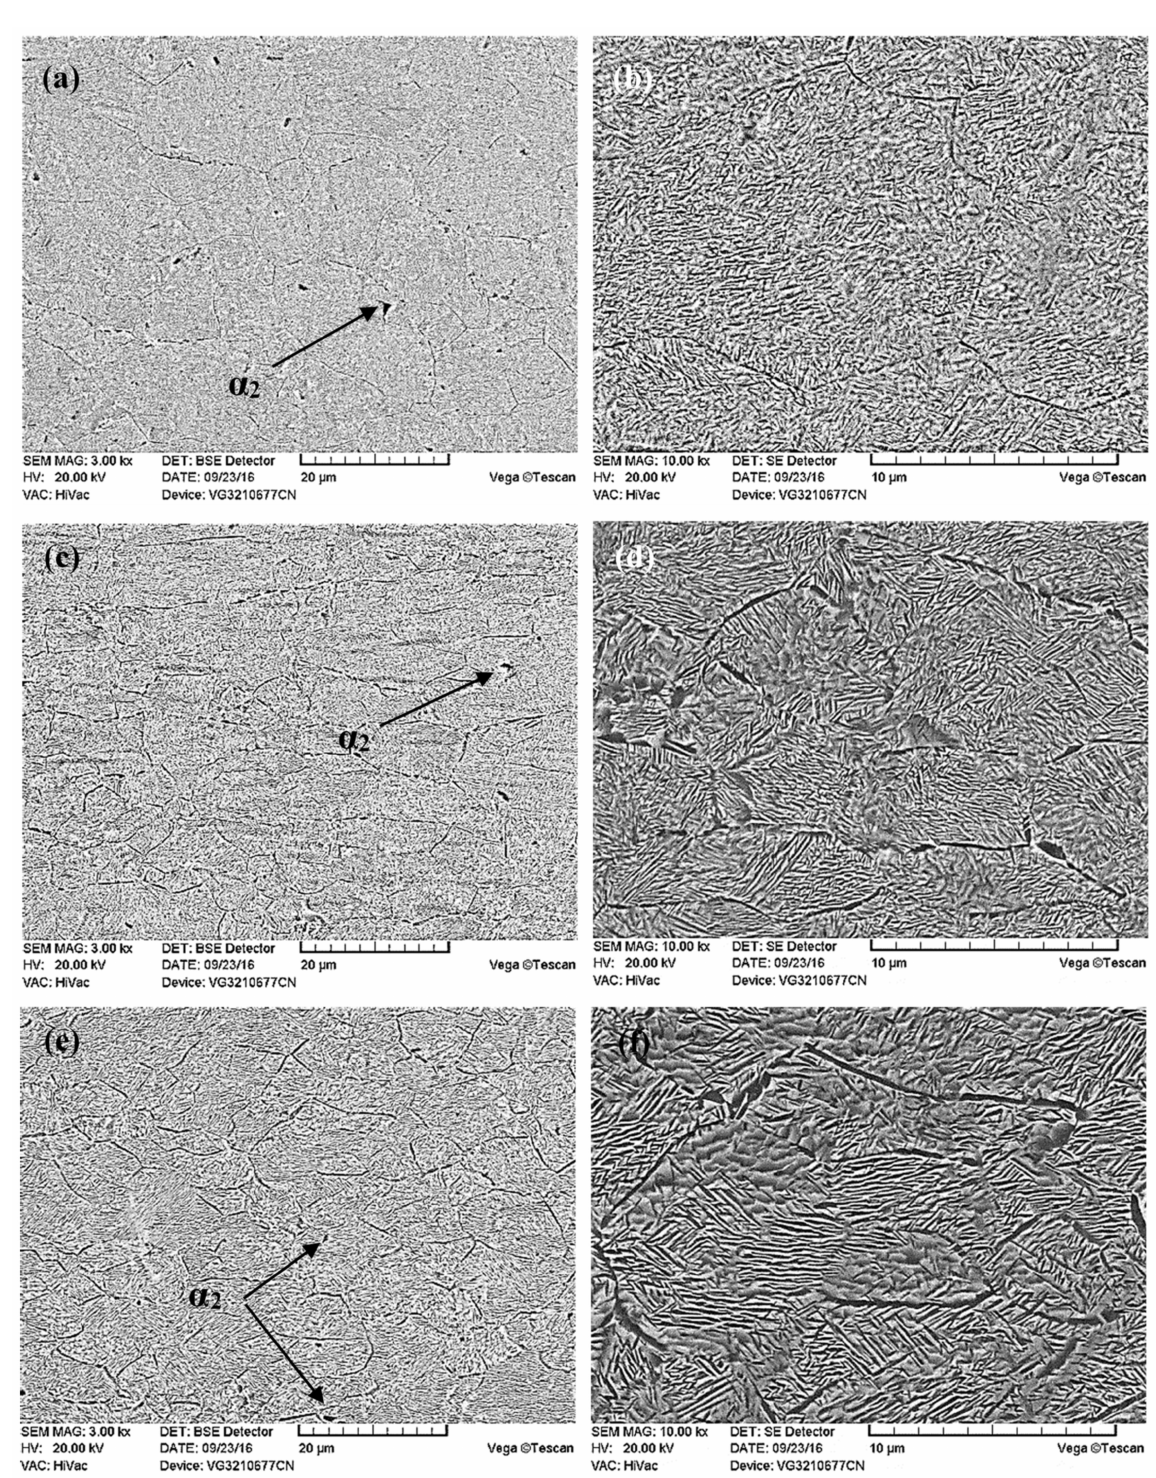
Figure 10. Micrographs of weld zone after aging treatment: ( a ) 760 ◦ C and ( b ) high magnification of the ( a ); ( c ) 800 ◦ C and ( d ) high magnification of the ( c ); ( e ) 840 ◦ C n and ( f ) high magnification of the ( e